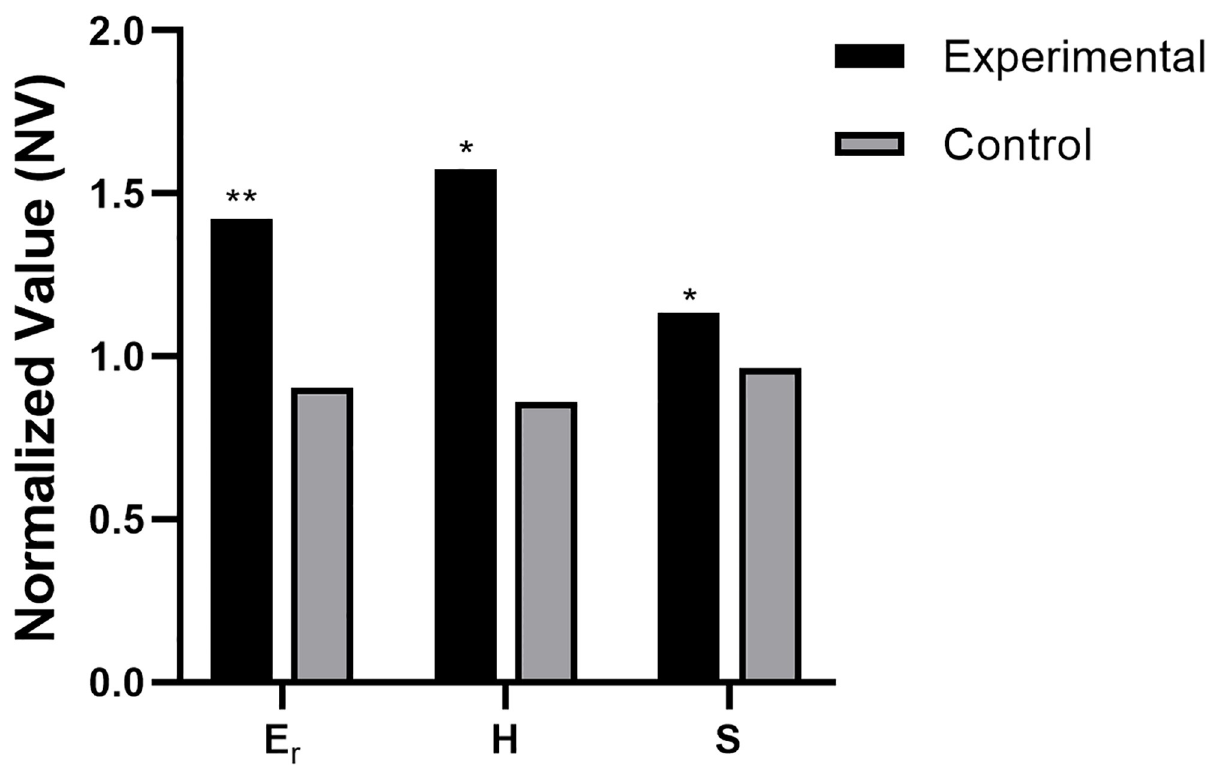
Fig 7. Normalized Value (NV) means ( ± standard deviation) for reduced elastic modulus, hardness, and stiffness comparing control specimen to treated specimen. Control NV is the mean of un-injected right knee joint divided by un-injected left knee joint. EGCG NV is the mean of EGCG- injected right knee joint divided by saline-injected left knee joint. NVs were calculated per each animal, then averaged for n = 3. ( � p < 0.05, �� p < 0.01).